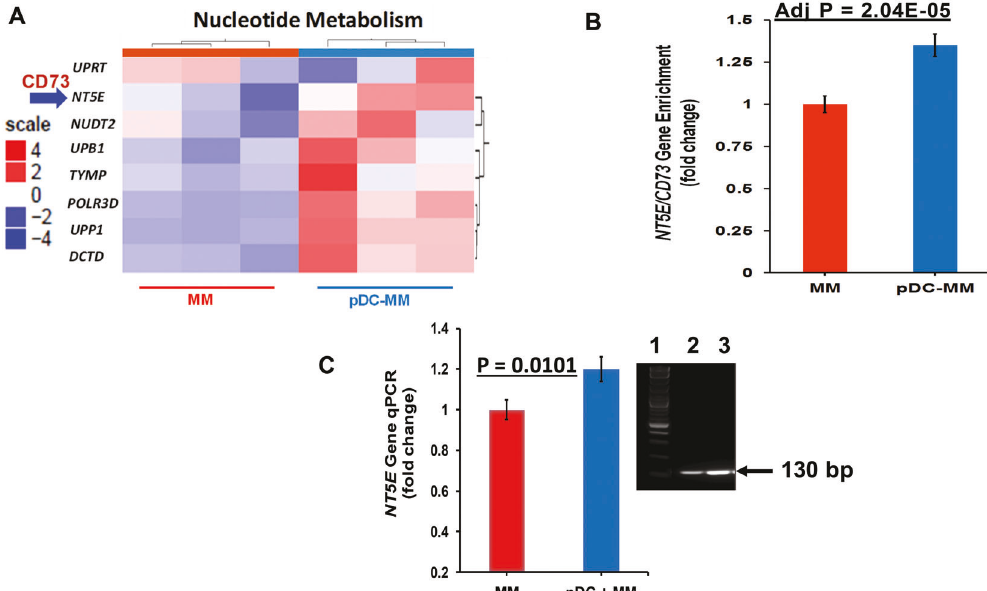
Fig. 2 Effects of pDC-MM interaction on nucleotide degradation pathway-related genes and clinical relevance of CD73 in MM. A Puri fi ed MM patient pDCs (from three MM patients) were co-cultured with MM.1S cells (1pDC/5MM) for 48 h, followed by separation of MM.1S cells from pDCs using fl ow cytometry. Total RNA from MM.1S cells was subjected to RNAseq analysis as in Fig. 1A. Hierarchical clustering analysis of RNAseq data show that pDCs alter purine/pyrimidine nucleotide degradation-related genes including ectoenzyme NT5E/CD73 in MM cells. B CD73 gene enrichment in pDC-MM cell coculture versus MM cells alone [1.34-fold upregulation; n = 3; Adjusted p = 2.04E -05]. C Validation and Quanti fi cation of NT5E gene expression by RT-qPCR: MM cells were co-cultured with pDCs for 48 h (in triplicate, n = 3); separated using CD138 antibody by fl ow sorting, and harvested. Poly RNA was subjected to RT-qPCR using Luna Universal 1-step RT-qPCR kit (New England BioLabs, MA, USA) following manufacturer protocol using an Applied Bioscience 7500 Fast Real-Time PCR System (Thermo Scienti fi c Inc). NT5E/CD73 gene expression was quanti fi ed from the raw data using ΔΔ CT and utilizing GAPDH as the housekeeping reference gene control under the experimental conditions. The bar graph denotes NT5E. gene expression in MM cells cultured in the presence vs absence of pDCs (mean ± SD; p < 0.05). Inset: Analysis of qPCR amplicons (130 bp) on a 2.5% agarose gel stained with GelRed Nucleic Acid Gel Stain (Biotium Inc, USA). Lane-1: 1 kb DNA ladder; Lane-2 and lane-3: NT5E expression in MM cultured in the absence and presence of pDCs,